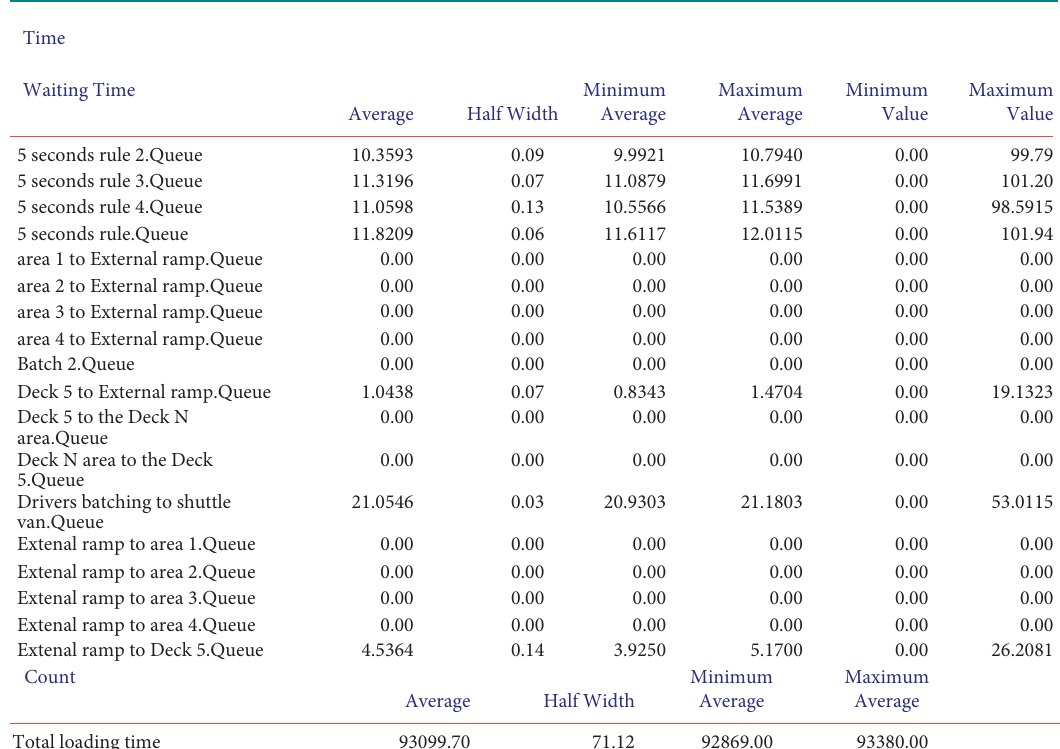
Figure 4: The simulation results for the current loading system. The longest waiting time was attributed to the batch delivery process, where drivers were collected by the shuttle van. The second-longest waiting time was attributed to the 5 s rule, which was applied to all vehicles to avoid collision with preceding vehicles. The total loading time was 93,099.70 s. As mentioned in Section 2.3.2, these results are similar to the actual data of port A. Table 2: Results for AGV loading system scenario 1. The simulation results are reported in the same way as in Figure 4 and we tested 10–40 AGVs. Number of AGVs